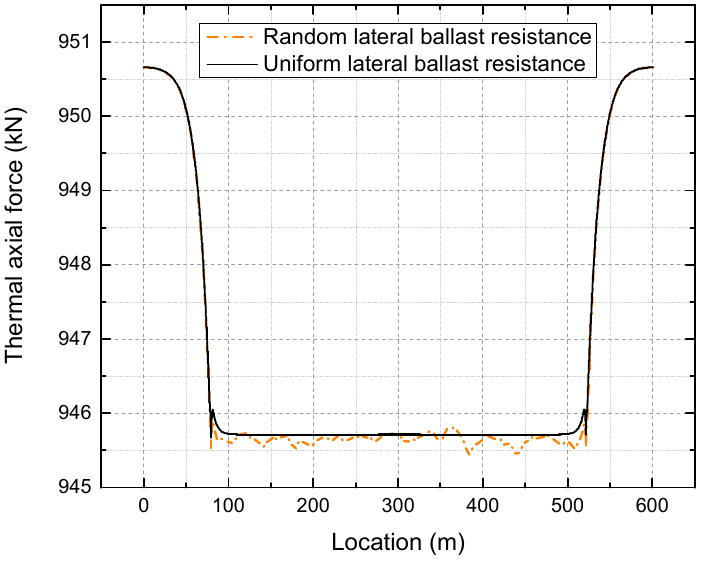
Figure 15. Thermal force after 50 °C temperature increase.